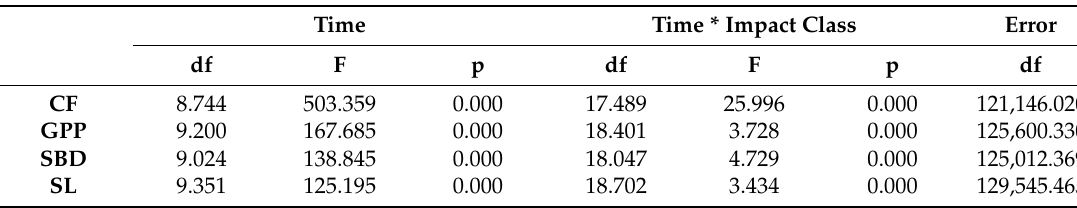
Table A1. Overall significance of differences in 2002–2012 phenology and green biomass production observed within the spatial representation of the 4nNDII7 PC, considered without and with stratification into drought impact classes (3 levels).